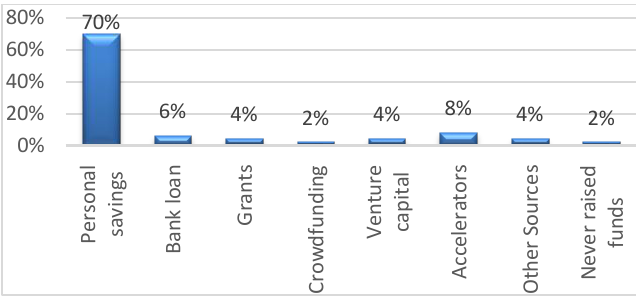
Figure 10: Source of Startup Funding ; Source: Author